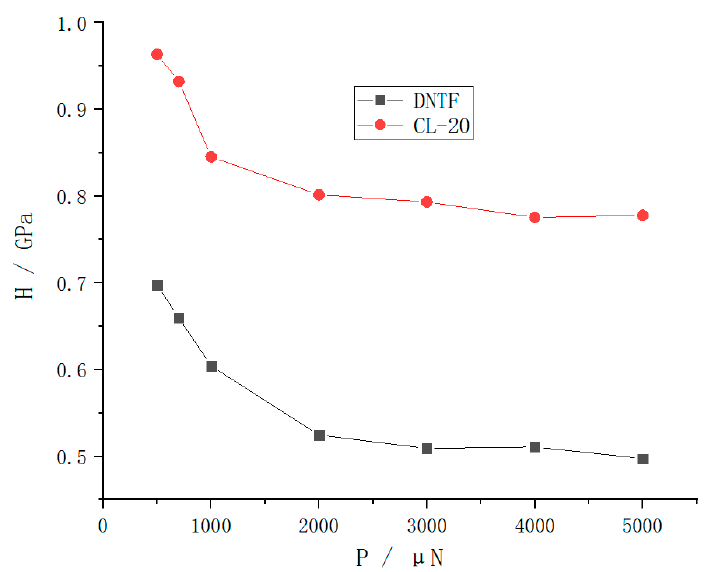
Figure 7. Load–crystal hardness curve.